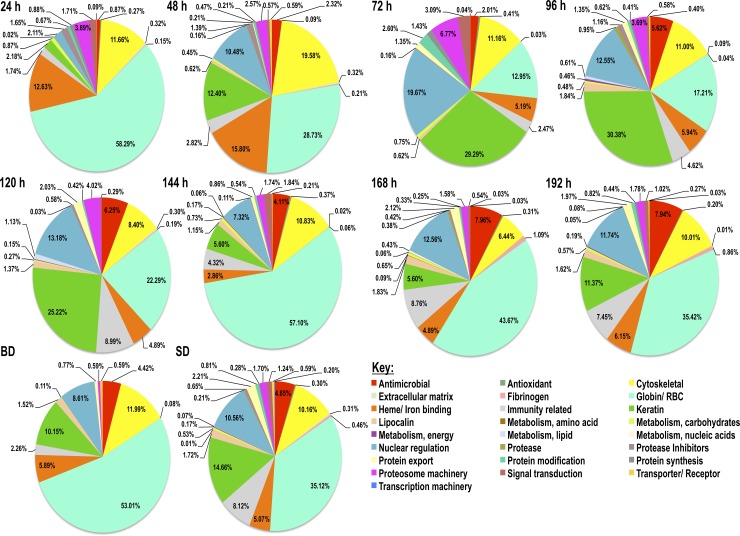
Rabbit host proteins composition in Amblyomma americanum tick saliva every 24 h during feeding.Pilocarpine induced A. americanum tick saliva was subjected to LC-MS/MS sequencing using the “In-Solution” digestion approach as described in materials and methods. Cumulative normalized spectral abundance factors (NSAF) values as index for relative abundance of detected rabbit host proteins are presented for each functional class. Please note the labels are oriented horizontally and read left to right starting from antimicrobial proteins (red), antioxidant/detoxification (green), cytoskeletal (yellow), then back to globin/RBC (light-green), fibrinogen (pink) and continues this pattern.